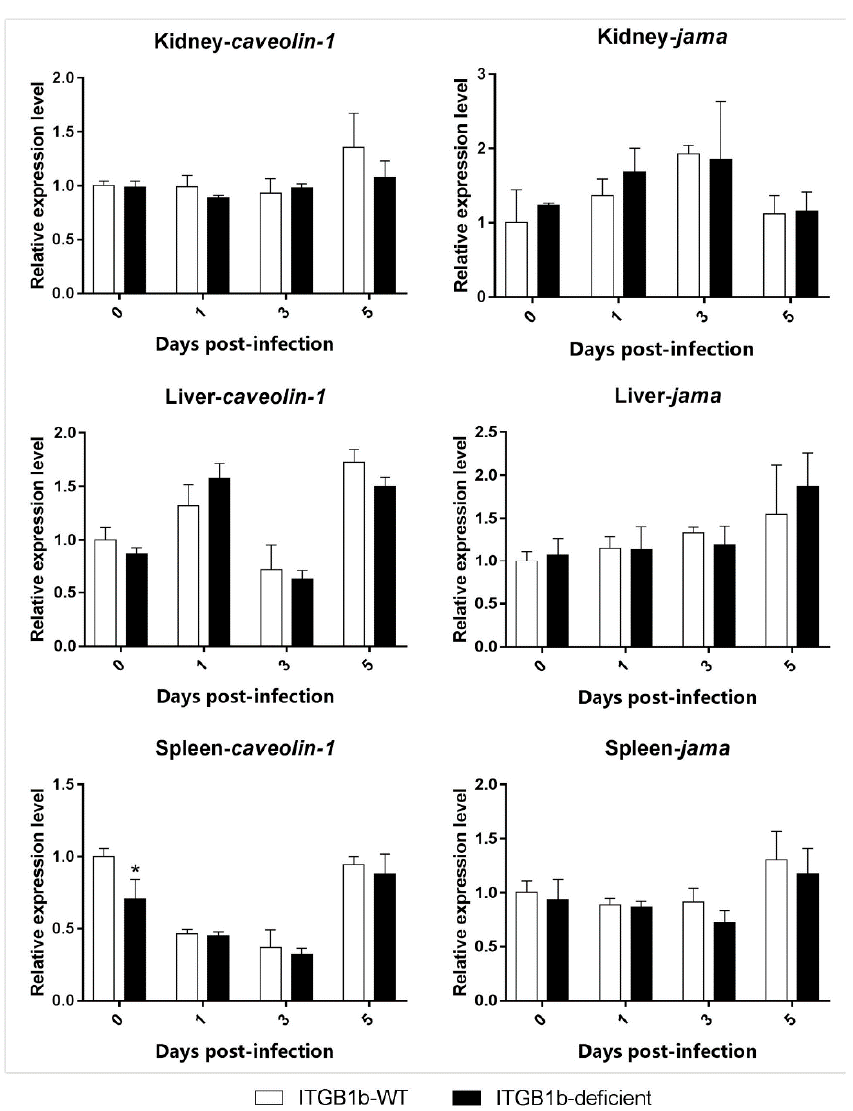
Figure 6. Expression of jama and caveolin-1 genes in ITGB1b-deficient and wild-type rare minnows. The relative expression levels were calculated as the ratio of gene expression level in ITGB1b-deficient fish relative to that in wild-type fish at 0 dpi. A significant difference ( p < 0.05, ANOVA) in gene expression level between the wild-type and ITGB1b-deficient and wild-type rare minnows is indicated with an asterisk (*).